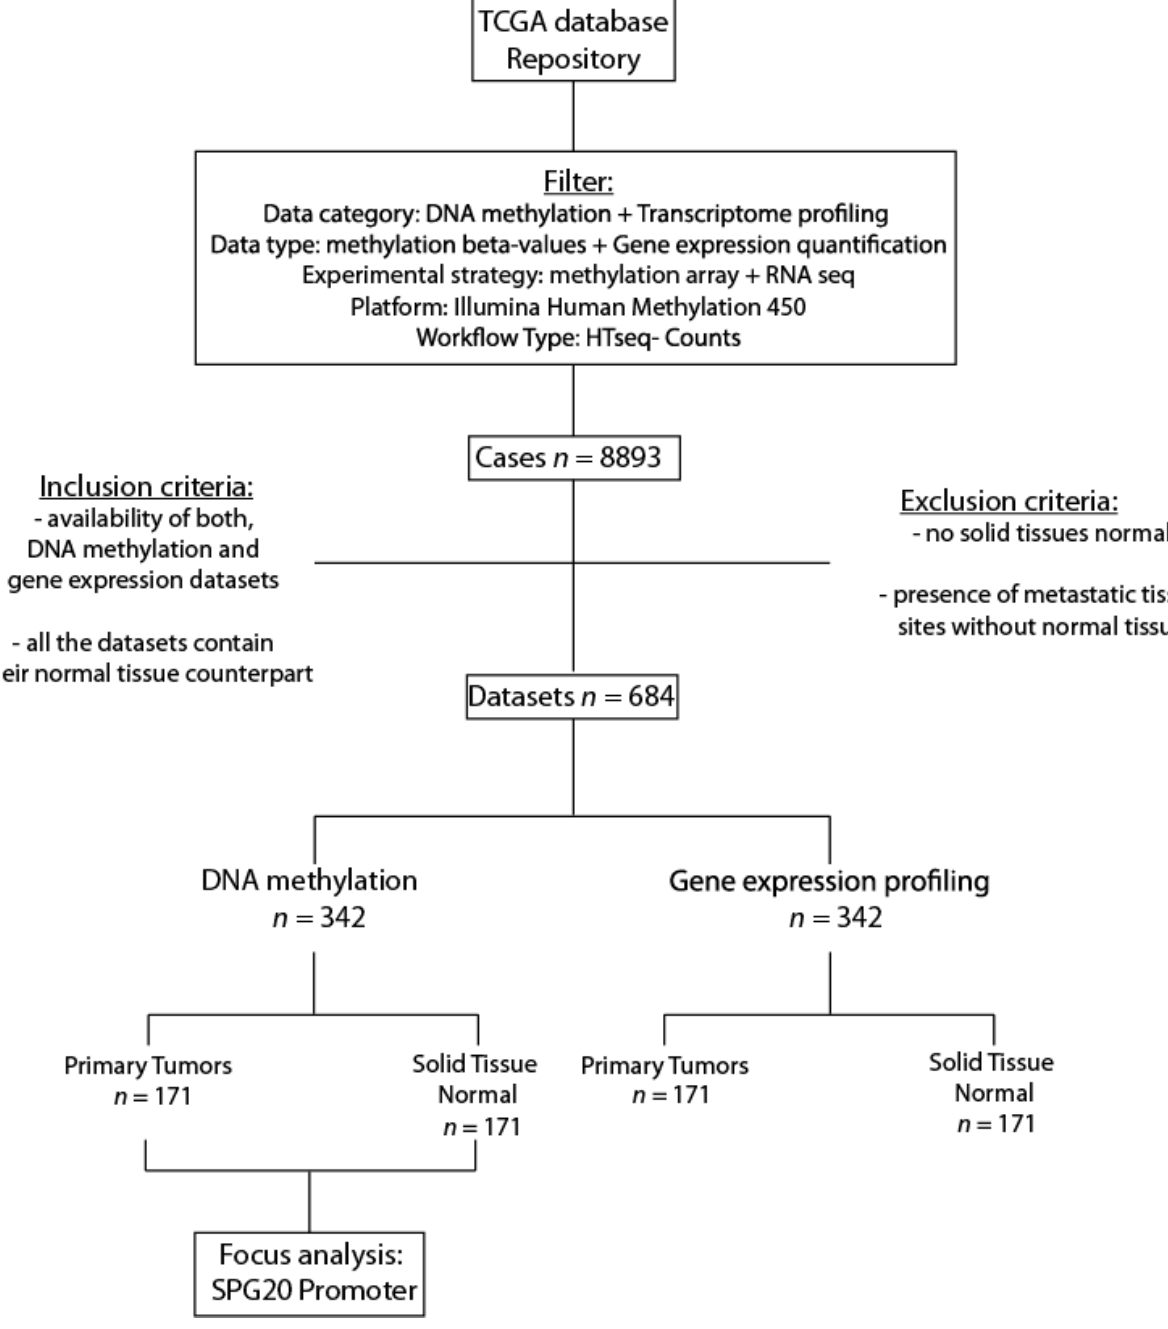
Figure 1. Algorithm of the workflow applied and described in the present research on The Cancer Genome Atlas (TCGA). The inclusion and exclusion criteria are specified.